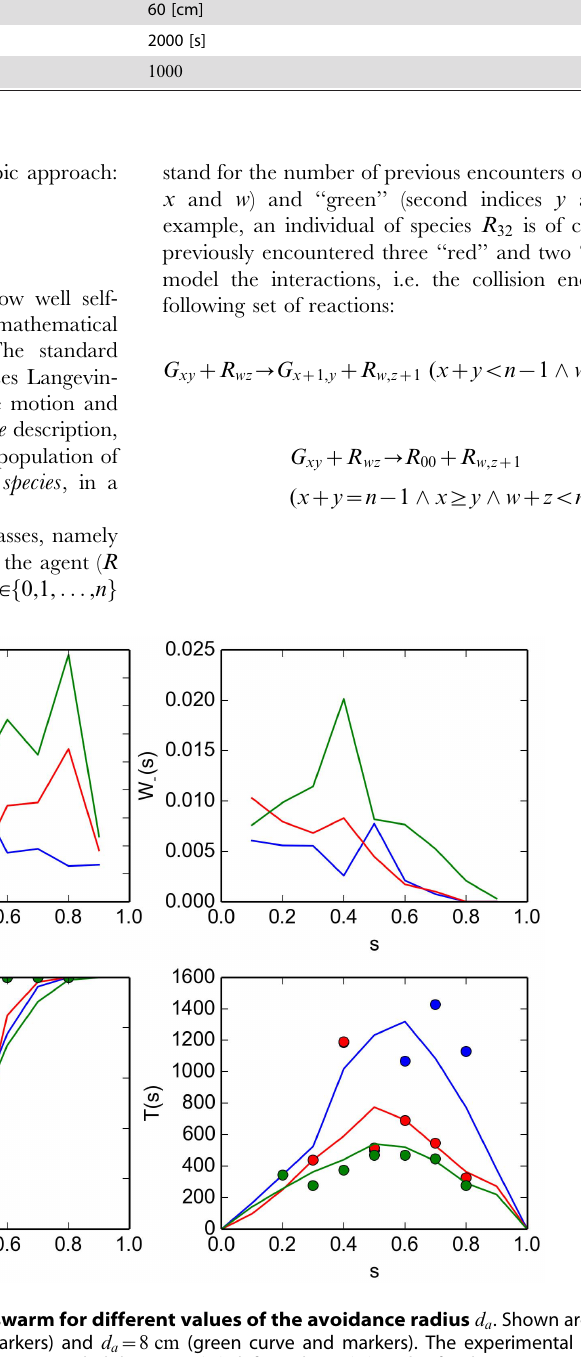
Speed of agents u